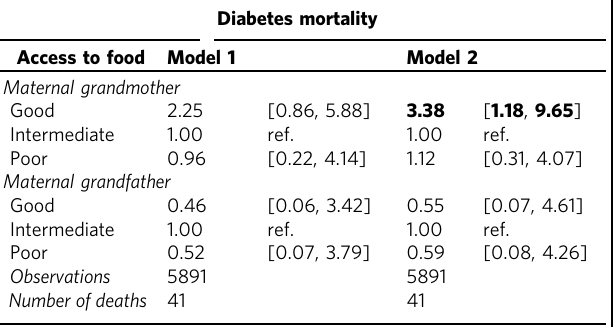
Table 3 Cancer mortality 1961 – 2015 in G2 men by paternal grandparents ’ harvest exposures in SGP: hazard ratios